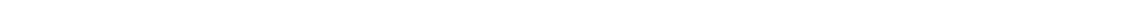
Fig. 2 Measuring and visualizing S1mplexes in vitro and within cells. a Dynamic light scattering of ssODN-S1mplex particle assembly. Cas9 (orange) and streptavidin (blue) proteins fail to assemble when in solution together and have a hydrodynamic radius consistent with published data. The addition of sgRNA to Cas9 protein increases the radius of the RNP particle to 10 nm (yellow). This radius does not change with the addition of streptavidin (red) and free streptavidin can be detected (red arrowhead). When S1m-sgRNAs are added to Cas9 (purple), the radius is increased by a larger amount than sgRNAs, potentially due to the larger size of the S1m-sgRNA-1. When streptavidin is added to this complex (green), a shift in size of about 3 nm occurs (green arrowhead), the size of streptavidin. A second peak at 35 nm (green asterisk) may be associated with multiple Cas9-S1m-sgRNA complexes connected to a single streptavidin. See also Supplementary Fig. 1c. b Two representative single cell multispectral fl ow cytometric images of S1m-sgRNA-1 and sgRNA-transfected cells with Cas9 immunohistochemistry and fl uorescent streptavidin (scale bar: 10 µ m). Arrowheads indicate presence of overlapping colors. Numbers in yellow are measured log Pearson correlation coef fi cient as determined by IDEAS software (see also Supplementary Fig. 2). c Correlation coef fi cient of Cas9 immunocytochemistry fl uorescent signal and streptavidin fl uorescence, as measured by multispectral image cytometry within hPSCs. Use of S1m-sgRNA-1 signi fi cantly increased the correlation between the two signals (*** p < 10 − 5 , Student ’ s two-tailed t test). d Representative confocal images of S1m-sgRNA-1 and sgRNA-transfected cells with Cas9 immunohistochemistry and fl uorescent streptavidin (scale bar: 5 µ m). Arrowheads indicate presence of overlapping colors. e Correlation coef fi cient of Cas9 immunocytochemistry and streptavidin fl uorescence inside the nuclei of transfected cells. Introduction of S1m-sgRNAs signi fi cantly increased the correlation between the two molecules (* p < 0.05, Student ’ s two-tailed